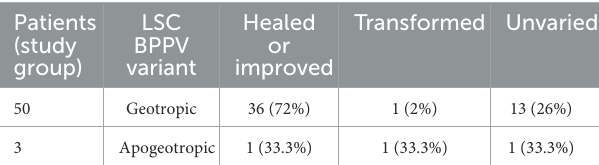
TABLE 1 Distribution of patients of the study group with regard to LSC BPPV variant and SFP